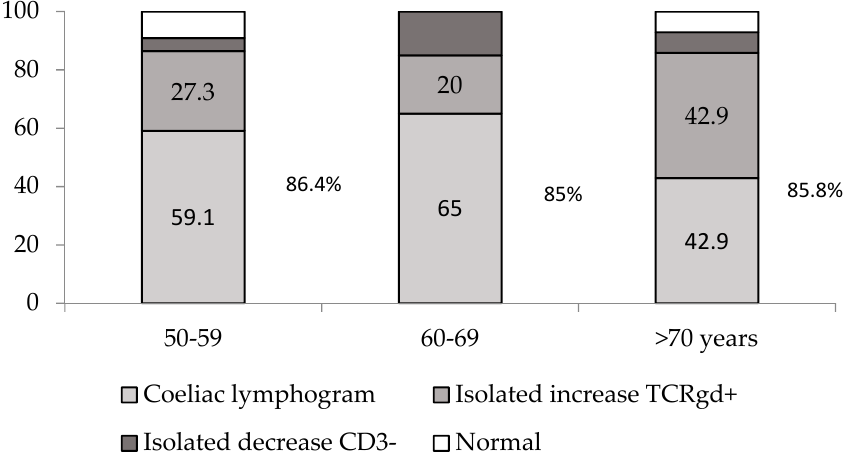
Figure 3. Flow cytometry patterns after a median of two years on a gluten-free diet, depending on the different age groups ( n = 56).